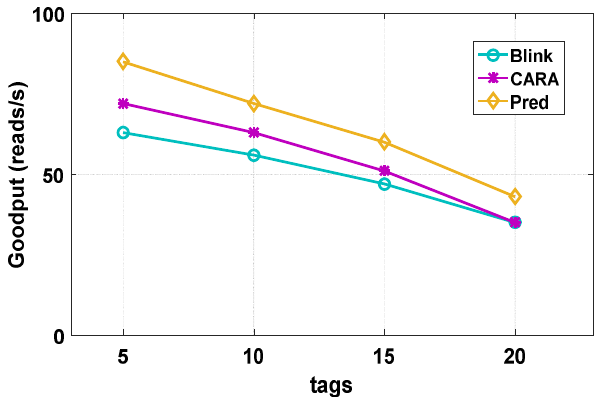
Figure 13. Stable environment.